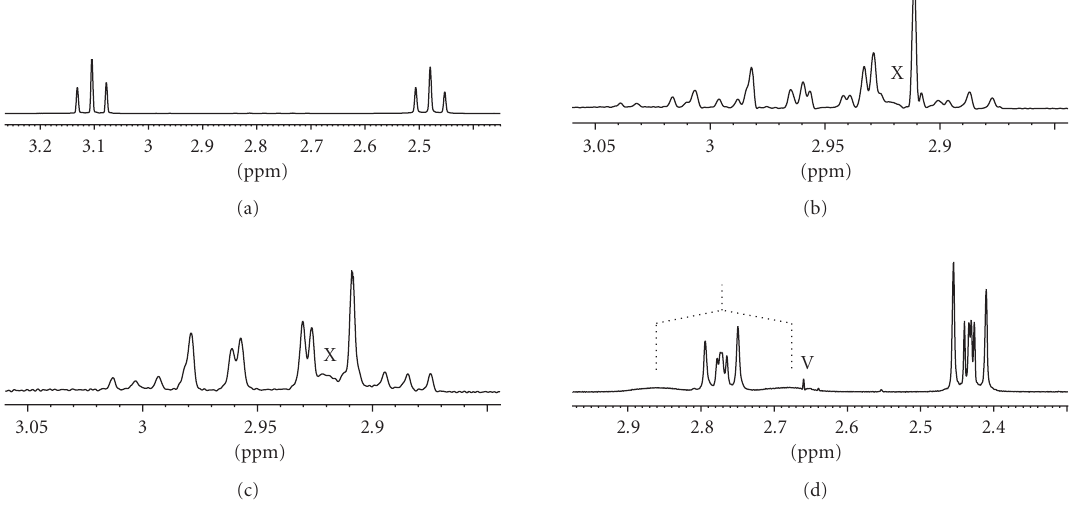
Figure 1: (a) PMR spectra in the region of CH 2 protons recorded in D 2 O for β -AlaH; (b) PMR spectra in the region of CH 2 protons recorded in acetone-d 6 for trans -[Pt( β -AlaH) 2 Cl 2 ]; (c) PMR spectra in the region of CH 2 protons recorded in acetone-d 6 with NH 2 proton coupling suppression for trans -[Pt( β -AlaH) 2 Cl 2 ]; (d) PMR spectra in the region of CH 2 protons recorded in D 2 O for cis -[Pt( β -Ala) 2 ]. X: broadened signal of the H 2 O admixture in acetone (spectra b and c); V: DMSO reference in D 2 O (spectrume d); : broadened doublet of splitting at 195 Pt (spectrume d).